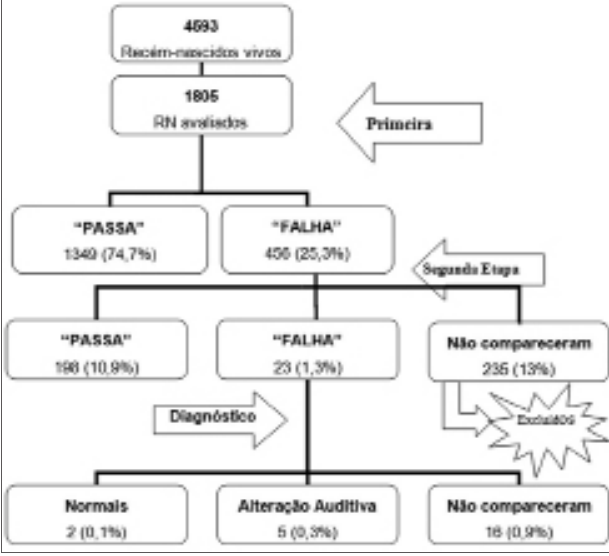
Figura 1. Número e porcentagem de crianças consideradas no Progra- ma de Triagem Auditiva Neonatal do Hospital Vereador José Storópolli Dos 1805 neonatos avaliados, 235 não compare- ceram na segunda etapa do Programa de TAN. Assim, foram estudados apenas 1570 recém-nascidos.